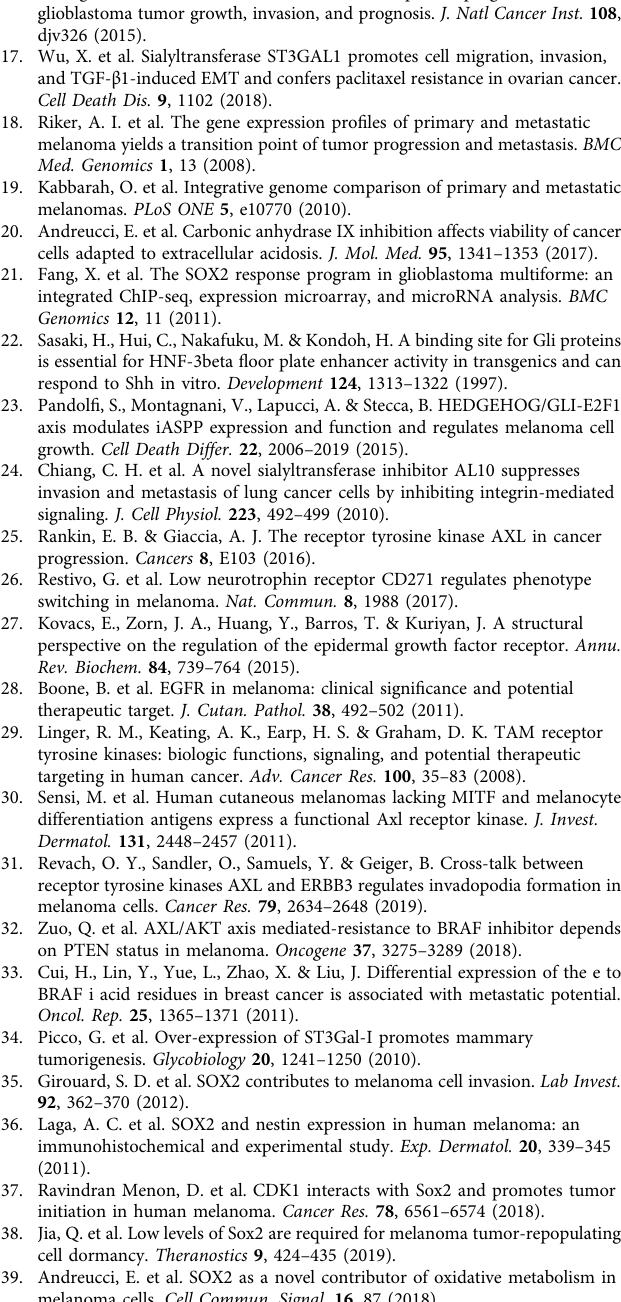
Fig. 8 AXL is the main mediator of the pro-invasive effect of ST3GAL1. a Western blot of ST3GAL1, AXL, and EMT markers in A375 M6 and MeWo cells transduced as indicated. HSP90 was used as loading control. b , c Matrigel invasion assays in A375 M6 and MeWo cells transduced as indicated. Data are represented as mean ± s.d. P value was calculated by ANOVA and Tukey ’ s test ( n = 3 biological independent experiments). d Representative images of A375 M6 as shown in b . e Average log-transformed normalized expression of AXL, GLI1, SOX2 , and ST3GAL1 in each sample. f Heat map of averaged expression of SOX2, ST3GAL1, GLI1 , and AXL in normal human neonatal epidermal melanocytes (N) and in patient-derived xenografts (M27, M12, M15). g UMAP visualization of 3322 melanoma patient-derived xenograft cells and normal human neonatal epidermal melanocytes, colored by log-transformed normalized expression of SOX2, GLI1, ST3GAL1, and AXL respectively. Numbers in the plots indicate cell clusters. h Western blot of SOX2, GLI1, ST3GAL1, and AXL in primary and metastatic patient-derived melanoma cells. i Proposed mechanism of action of the SOX2/GLI1-ST3GAL1-AXL axis. ST3GAL1 is transcriptionally regulated by both GLI1 and SOX2 and drives melanoma cell invasion and metastasis. ST3GAL1 induces ligand-dependent AXL dimerization and consequent autophosphorylation at residue Tyr702. Blots in a and h are representative of n = 3 biological independent experiments. HSP90 and GAPDH were used as loading controls. Source data are provided as Source Data